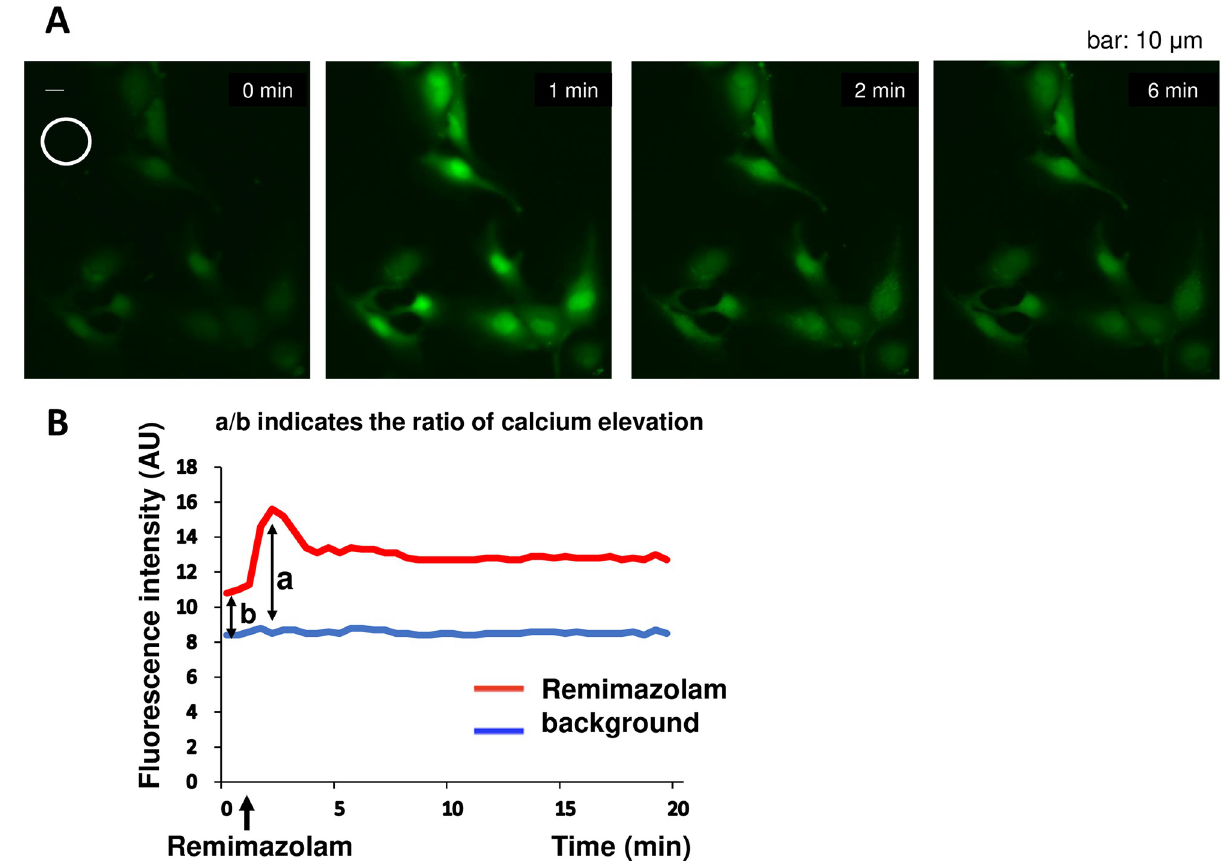
Fig 1. Remimazolam-induced intracellular calcium elevation. (A) An example of a typical remimazolam-induced intracellular calcium elevation time series in HUVECs. Approximately one min after the administration of 300 μ M remimazolam, an increase in the fluorescence intensity of Fluo-4 was observed, indicating that intracellular calcium was increased. Fluorescence intensity in the circled area was used as background. (B) The method of semi-quantifying the rate of calcium elevation. The red line indicates the average fluorescence change over the entire observed region. The blue line indicates the fluorescence change in the background region without cells. The differences between both lines before the remimazolam application (b) and at the peak of calcium elevation (a) were measured. The ratio a to b (a/b) was considered as an index of remimazolam-induced calcium elevation.